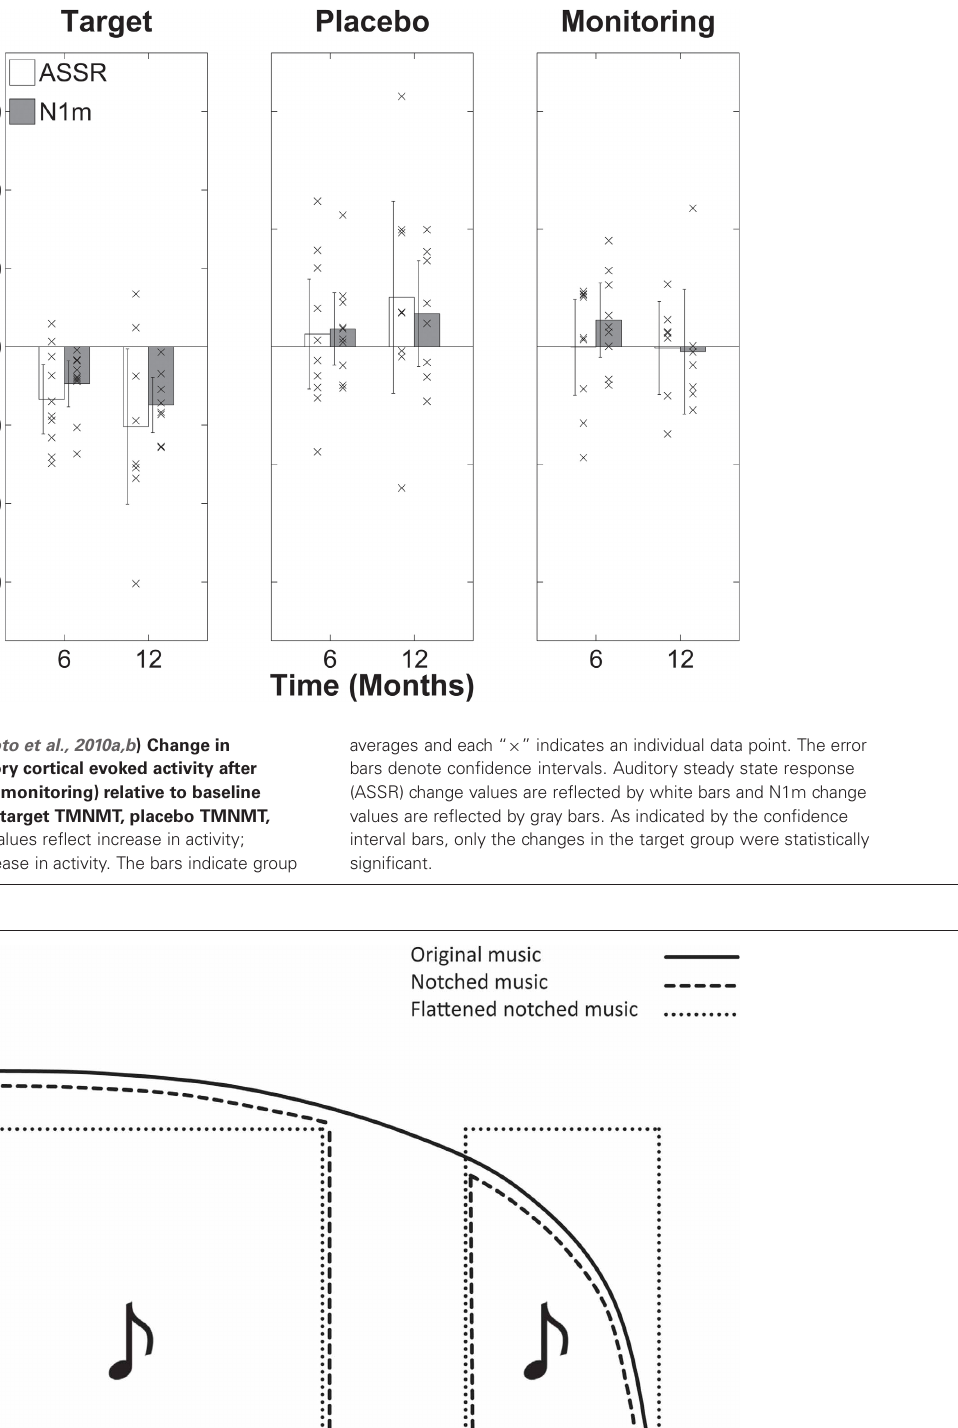
FIGURE 10 | Schematic illustration of the energy spectra of original (i.e., unmodified) music (black line), notched music (green line), and flattened notched music (blue line). The red arrow indicates the tinnitus frequency, at which the notches are centered.